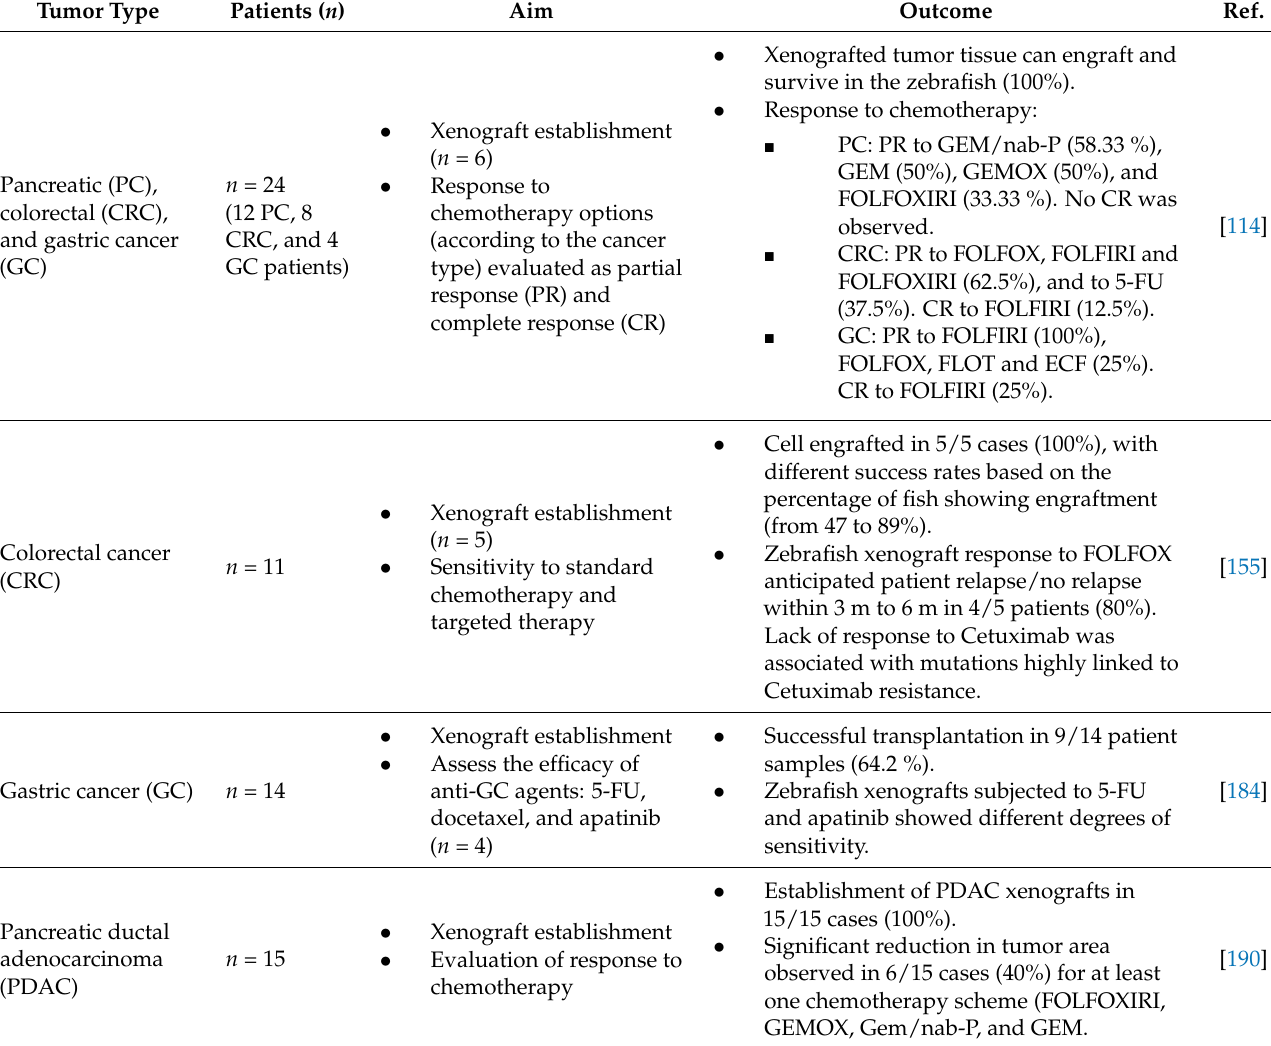
Table 3. Studies involving the use of zebrafish PDXs for drug efficacy and